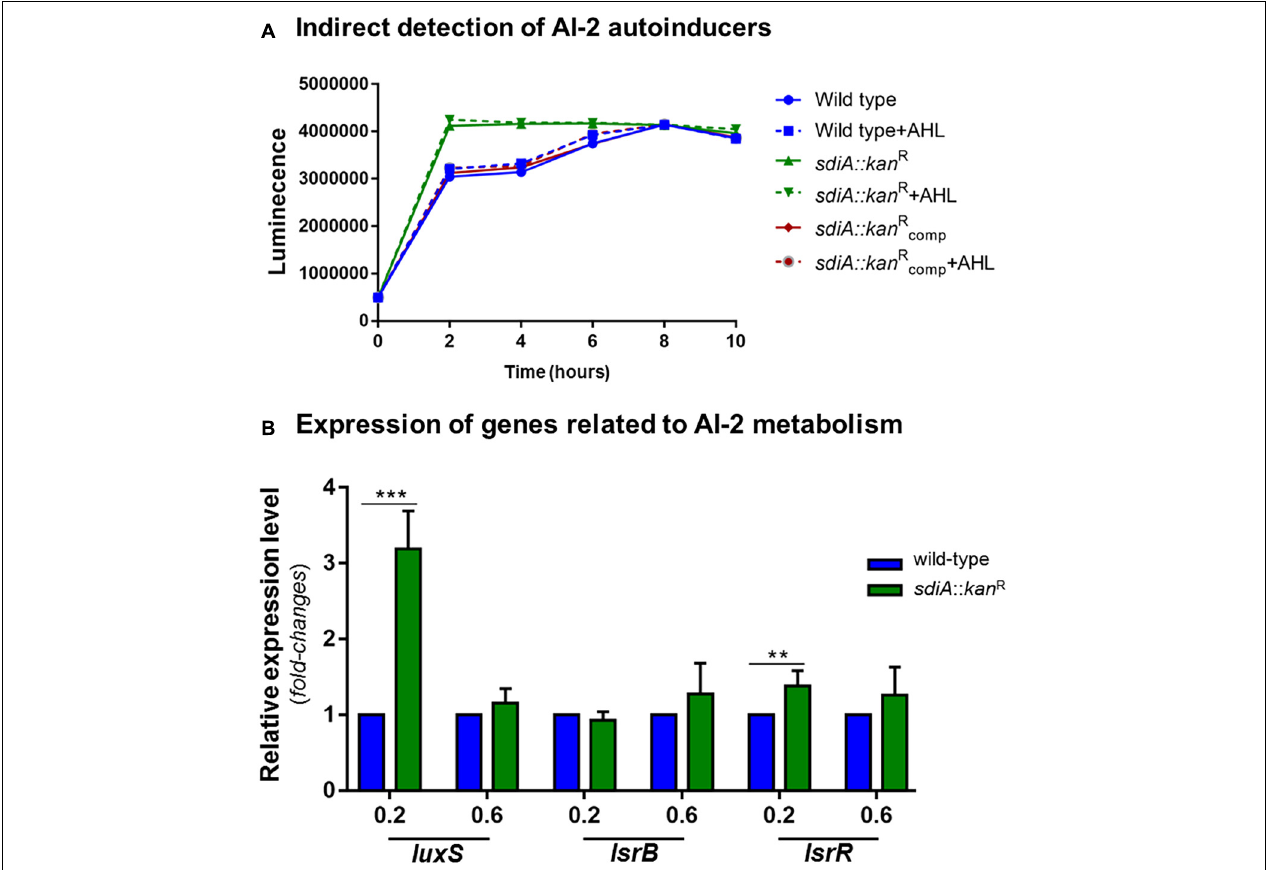
FIGURE 5 | K. pneumoniae cells lacking SdiA regulator reach maximum production of AI-2 QS signaling molecules earlier and present up-regulation of luxS and lrsR . (A) Cell-free supernatants were collected from wild-type and sdia :: kan R mutant strains cultured at the indicated O.D. and tested for AI-2 production by indirect measuring the level of bioluminescence induced in the V. campbellii MM32 reporter strain. The mutant strain reaches maximum production of AI-2 after 2 h of culture, while the wild-type and complemented strains reached maximum production of AI-2 only after 8 h of culture. The addition of AHL had no effect on the production of AI-2 molecules by the K. pneumoniae strains. (B) The absence of SdiA causes up-regulation of luxS and lsrR genes, which encode the AI-2 synthase and the LsrR repressor, respectively. No change in the expression of lsrB (receptor of AI-2 molecules) was observed between the wild-type and mutant strains. Gene expression analysis were performed by RT-qPCR on the wild-type and mutant K. pneumoniae strains cultured at O.D. 600 nm of 0.2 and 0.6. Error bars represent the standard deviation. Statistically significant differences between the strains were analyzed by multiple t -test (** p < 0.01; *** p <